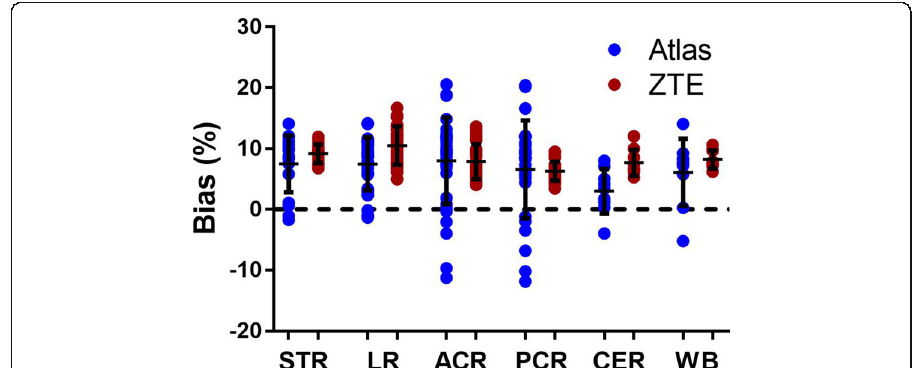
Fig. 3 Relative bias in SUV after use of ZTE- or atlas-attenuation correction (AC) compared to 68 Ge-AC for different regions of interest. STR, striatum; LR, limbic regions; ACR, anterior cortical regions; PCR, posterior cortical regions; CER, cerebellum; WB, whole-brain. Bars and whiskers are mean ± SD